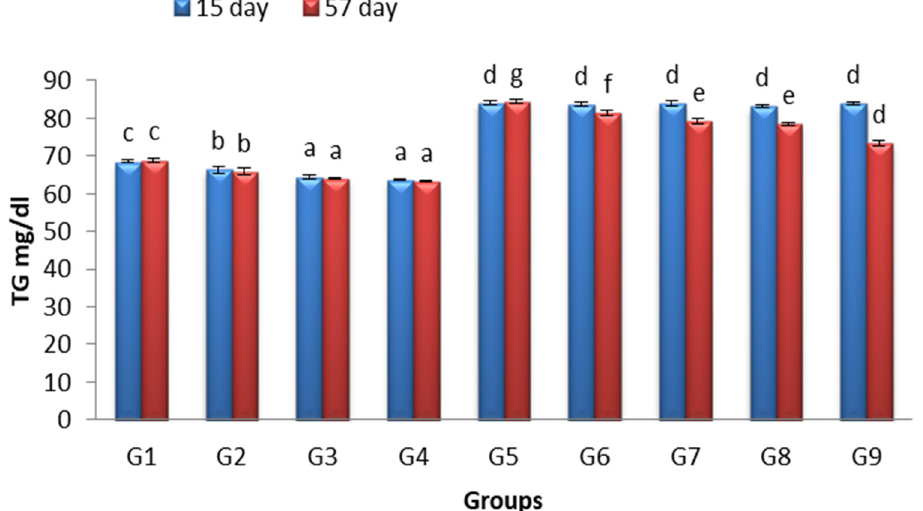
Figure 3. The influence of L. plantarum (Lp), L. casei (Lc), S. platensis (Sp) and their combination on triglyceride (TG) level in albino mice (mg/dl) at 15 days and at the end of experiment. Error bars represent SE of mean. G1: regular diet (RD); G2: RD + Lp + Lc; G3: RD + Sp; G4: RD + Lp + Lc + Sp; G5: high-cholesterol diet (Ch); G6: Ch + Lp + Lc; G7: Ch + Sp; G8: Ch + Lp + Lc + Sp; G9: Ch+ rosuvastatin. Bars with different superscript are significantly different ( p < 0.05).